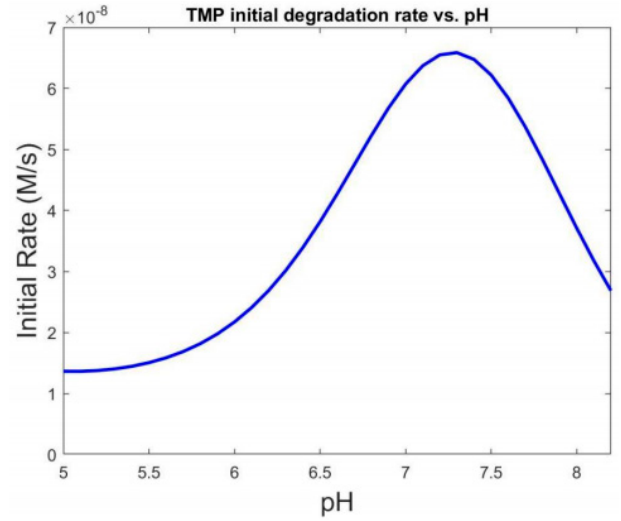
Figure 1. The initial chlorination rates of TMP under the various pH conditions.